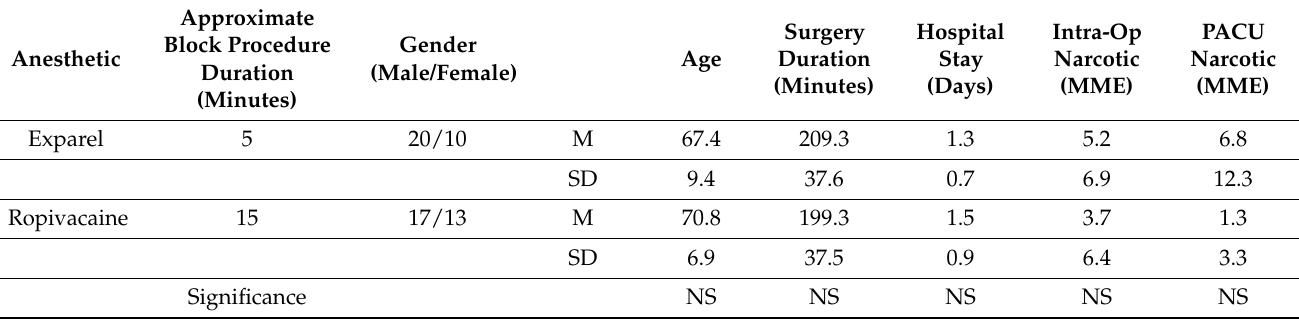
Table 1. Characteristics of the two patient